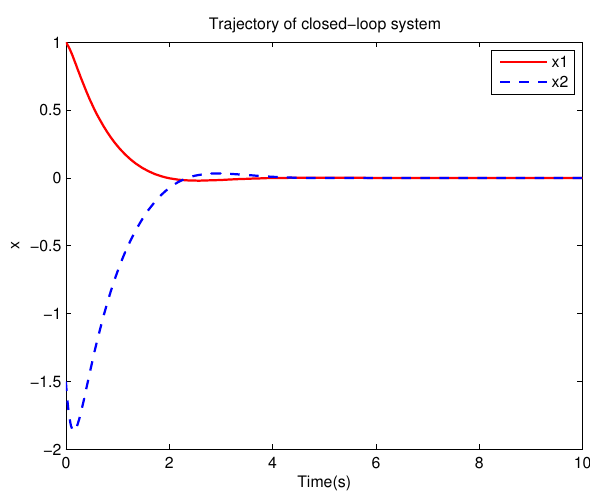
Figure 15. Closed loop system trajectory, p 1 = 1, p 2 =